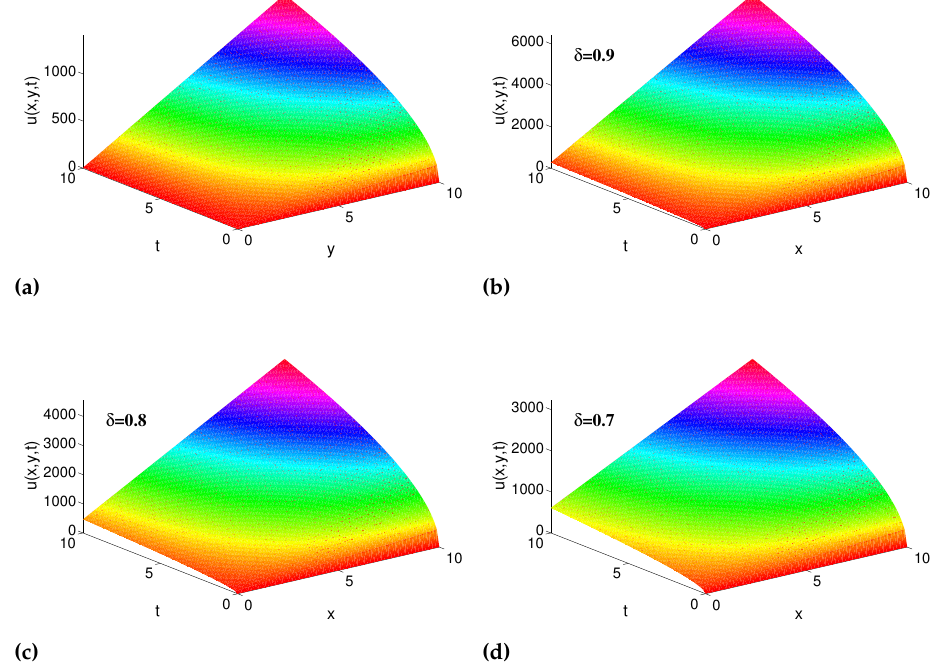
Figure 2. The numerical simulations of Equation (10) with ( a ) δ = 1, k = 3 ( b ) δ = 0.9, k = 3 ( c ) δ = 0.8, k = 3 ( d ) δ = 0.7, k = 3 and y =